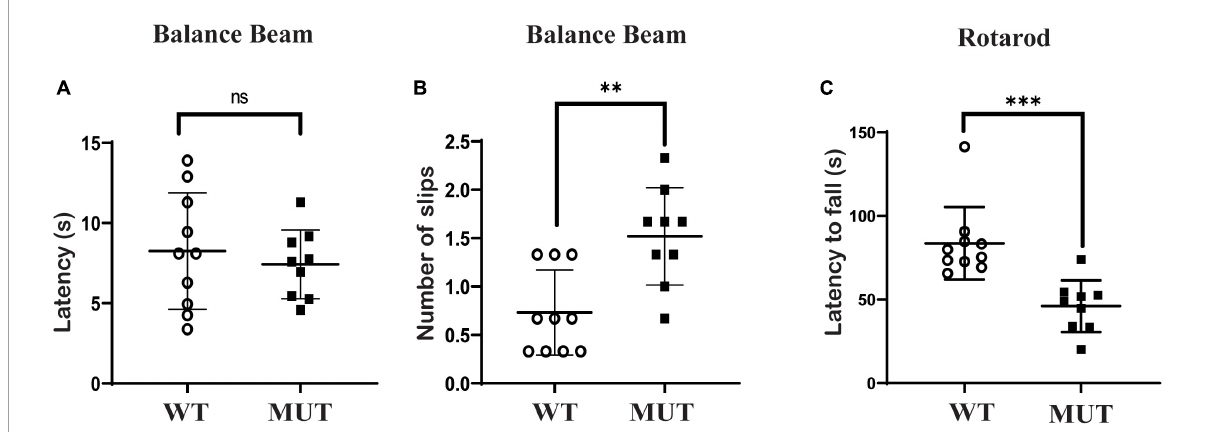
FIGURE3 Timm8a1 I 23 fs 49 X / I 23 fs 49 X MUT mice presented with mildly impaired coordinative ability and impaired maximal motor performance. (A,B) Balance beam test. The MUT mice took a similar time to cross the beam compared to the wild-type (WT) mice (WT = 8.26 ± 3.63, n = 10, MUT = 7.43 ± 2.15, n = 9, P > 0.05), while the MUT mice slipped more frequently on the balance beam than the WT mice (WT = 0.73 ± 0.44, n = 10; MUT = 1.52 ± 0.50, n = 9, ∗∗ P < 0.01). (C) Rotarod test. The MUT mice stayed less time on the rod than the WT mice (WT = 83.65 ± 21.69, n = 10; MUT = 46.02 ± 15.44, n = 9, ∗∗∗ P < 0.001). Error bars represent mean ±